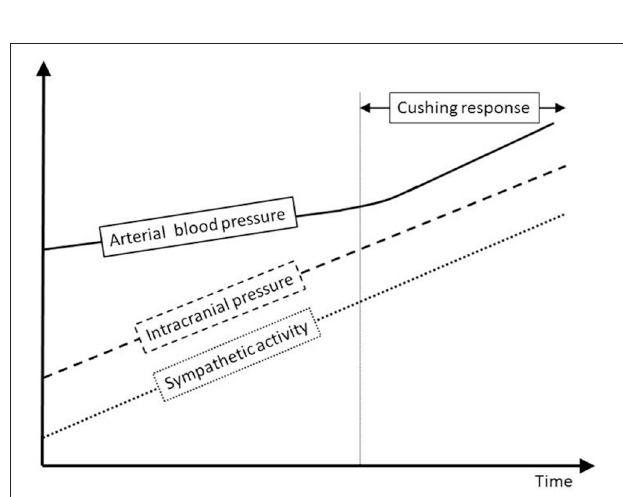
FIGURE 9 | Sympathetic and ABP response to ICP increase. This schematic figure is an attempt to display our hypothesis about the interplay between ICP, sympathetic activity and ABP. Modest ICP increase augments pari passu sympathetic activity that parallels the ICP rise, but has a mild influence on ABP. For higher ICP values, the increase in sympathetic activity yields an ABP rise that heralds the Cushing response, very last hemodynamic consequence of a continuous ICP-mediated sympathetic